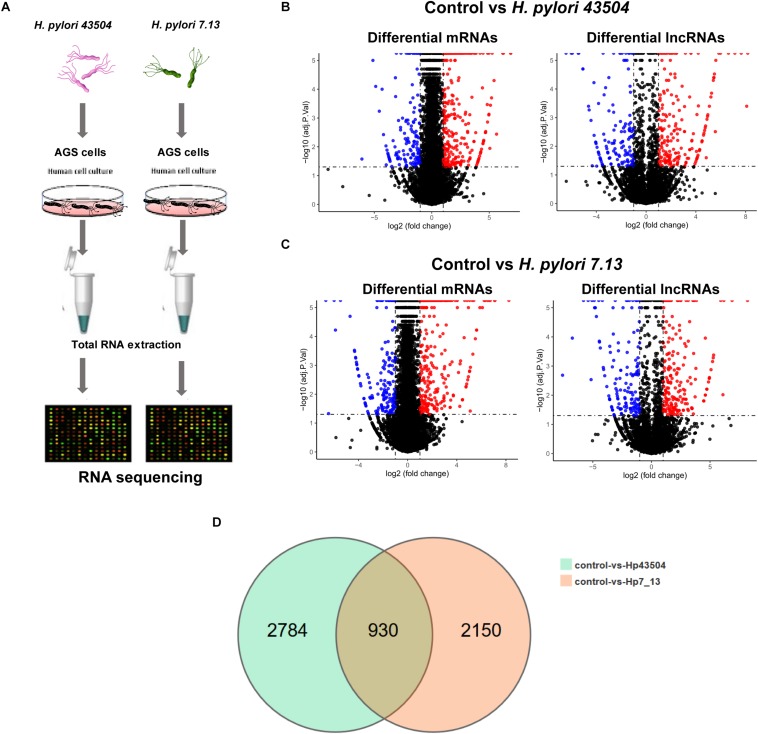
Overview of the RNA sequencing results in gastric epithelial cells infected with H. pylori. (A) Schematic view of the experimental workflow for transcriptome sequencing in AGS cells infected with H. pylori. (B) The volcano plot shows the differentially expressed mRNAs and lncRNAs between uninfected and H. pylori 43504-infected cells. (C) The volcano plot shows the differentially expressed mRNAs and lncRNAs between uninfected and H. pylori 7.13-infected cells. (D) The Venn diagram shows overlapping genes of significantly differentially expressed genes following H. pylori infection.